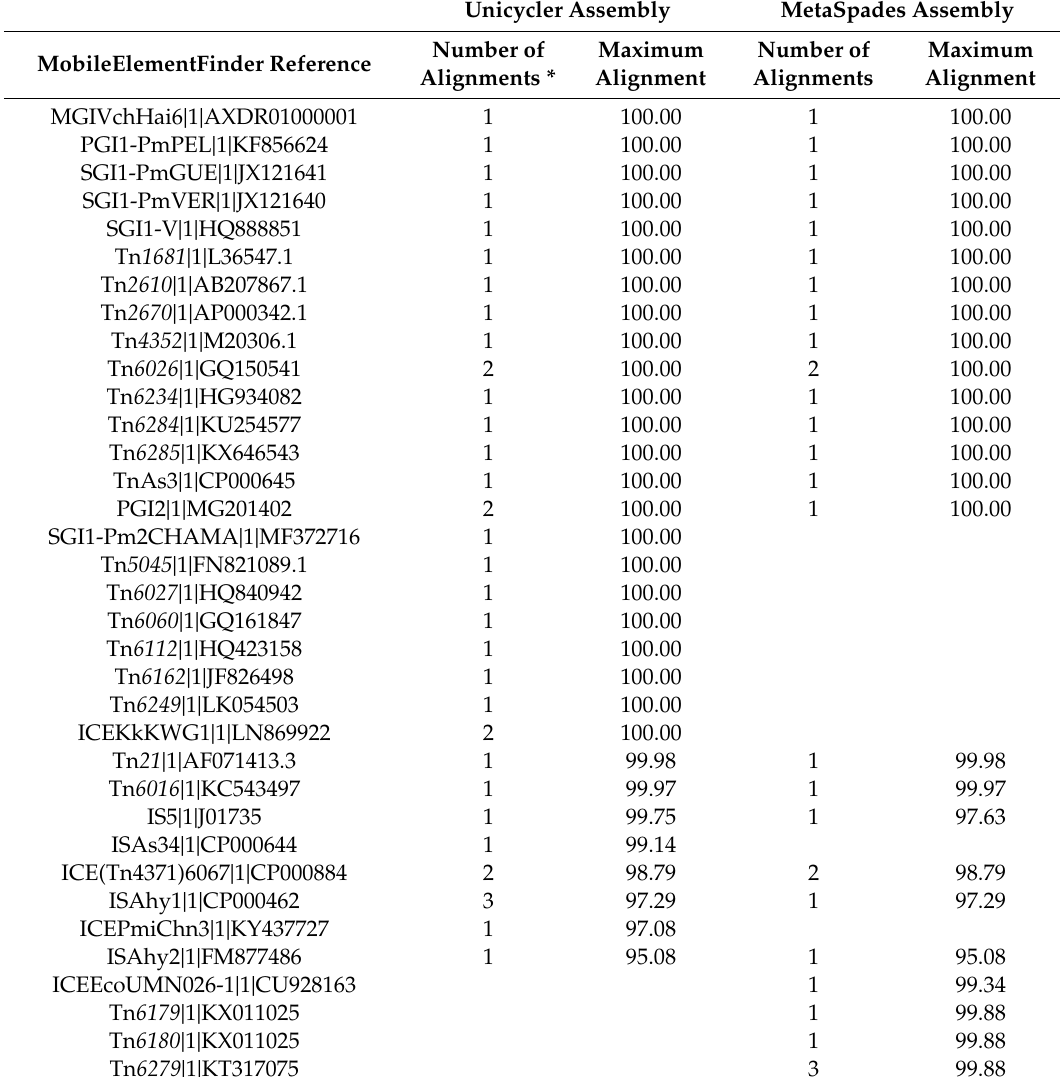
Table 3. Alignment of Aeromonas hydrophila CVM861with sequences from the MobileElementFinder database. MobileElementFinder Reference